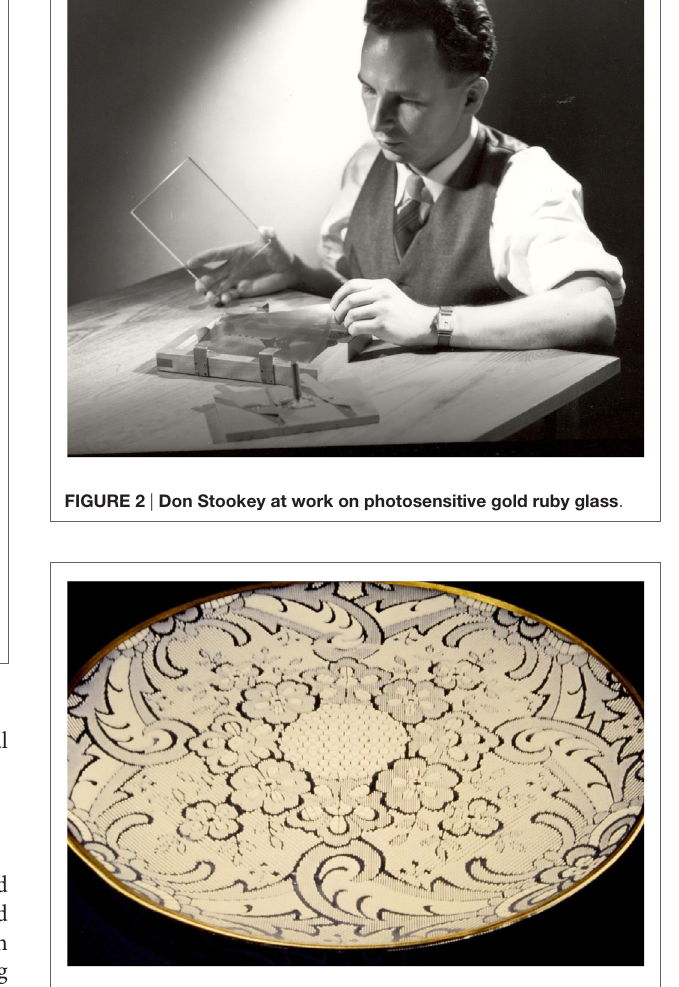
FiGURe 3 | Fotalite ® dinner plate design .